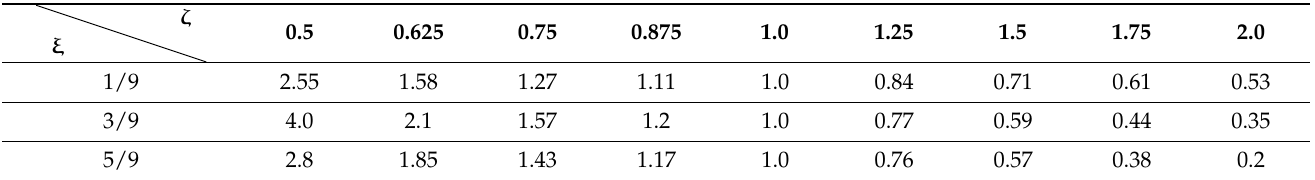
Table 2. Estimated limit values of the fracture shape coefficient η with respect to the fracture toughness contrast ζ and the proportion of pay zone ξ